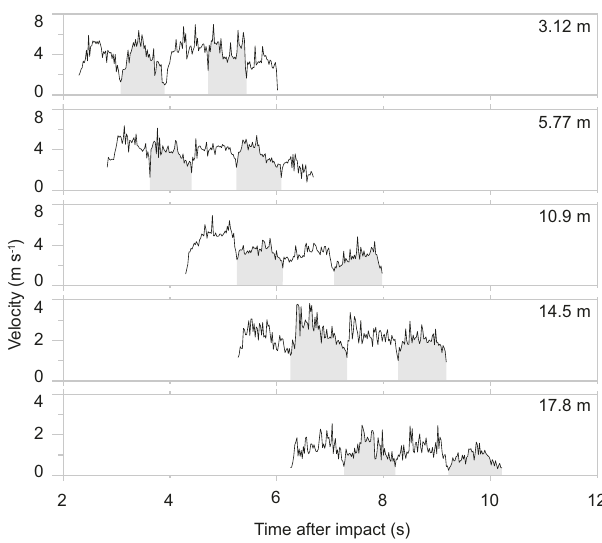
Fig. 4 Spatial evolution and downstream propagation of low-frequency fl ow oscillations. Time-series data of velocity magnitude against time in the middle of the jet region (at a fl ow height of 0.8 m) at static observer locations situated at runout distances of 3.12 m, 5.77 m, 10.9 m, 14.5 m, and 17.8 m. The regular low-frequency oscillation pattern can be tracked downstream. White and grey shaded areas outline the approximate periods of oscillation. The duration of these periods increases only slightly during fl ow runout from c. 800 – 1000 ms and have an average duration of 870 ms.